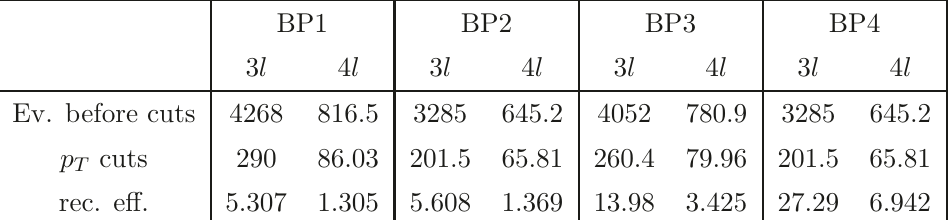
H 1 ν h ν h ) multiplied → →